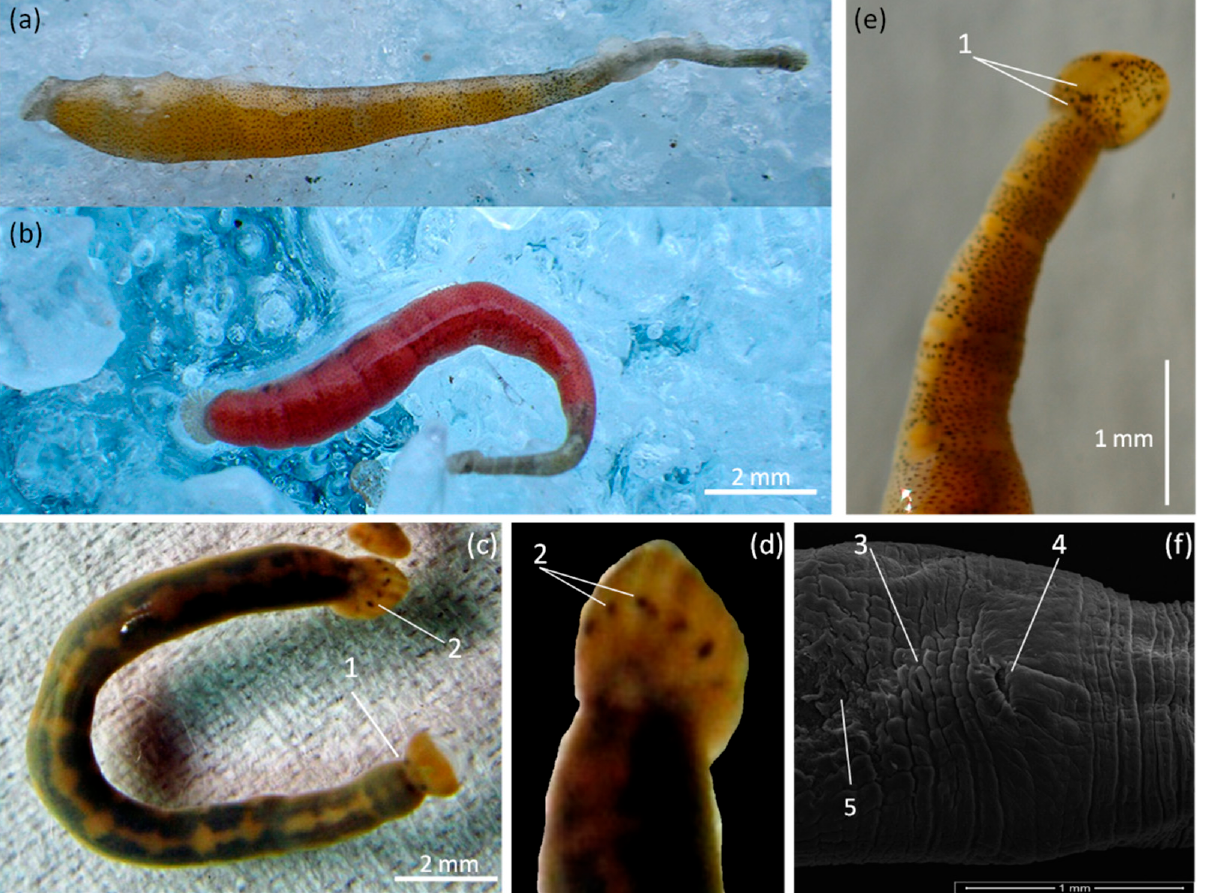
Figure 7. Morphology of Piscicola khubsugulensis sp. nov.: ( a , b ) body proportions and pigmentation of living individuals (voucher C183-184), ( b ) the glow of the spermatophore, ( c ) fixed specimen (voucher X495), ( d ) posterior sucker, ( e ) anterior sucker and trachelosome and ( f ) body fragment with genital openings of the X495 specimen (SEM). Numerical designa: 1—eyes, 2—eye-like spots, 3—female genital opening, 4—male genital opening and 5—copulatory gland.